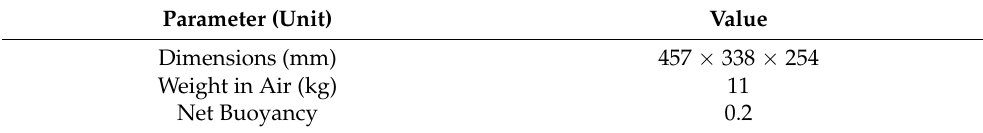
Table 2. Physical parameters of the BlueROV2.